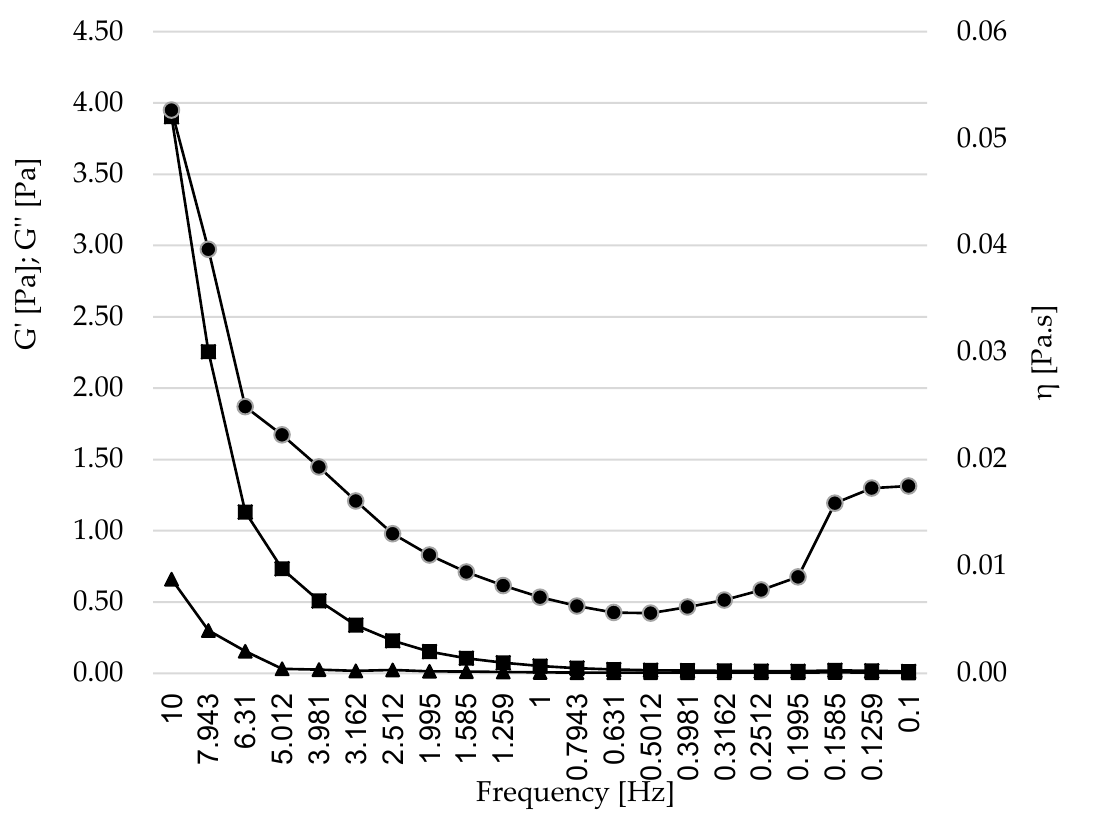
Figure 7. Rheological behavior of the LN6 dispersion (containing 0.6% of SL and 1% of Tween ® 80).